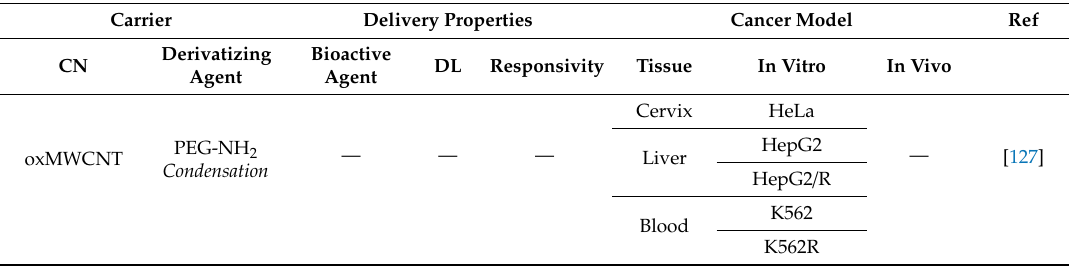
Table 2. MDR reversal by CN via inhibition of e ffl ux